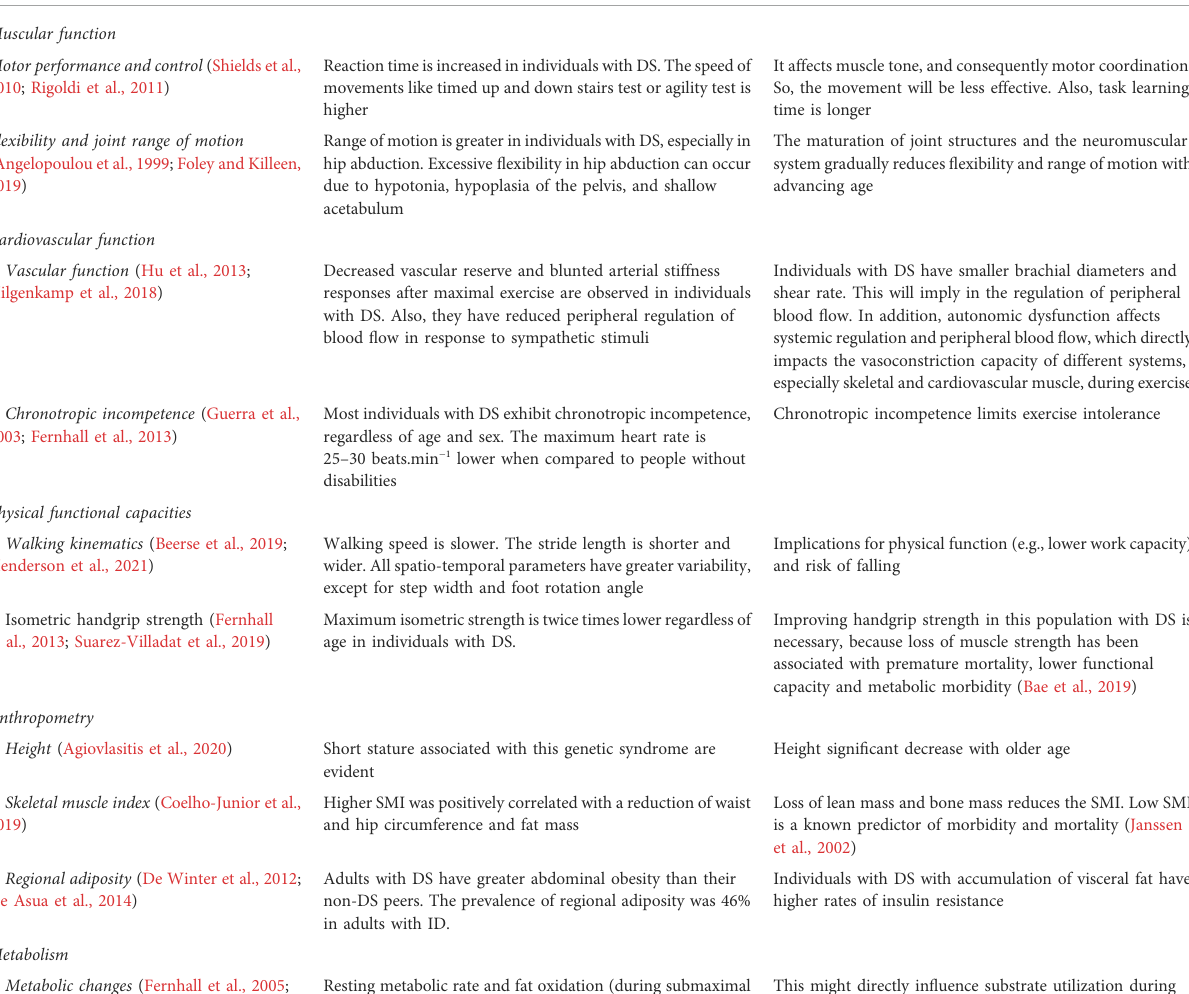
TABLE 1 Summary of Down Syndrome effects on structural and functional